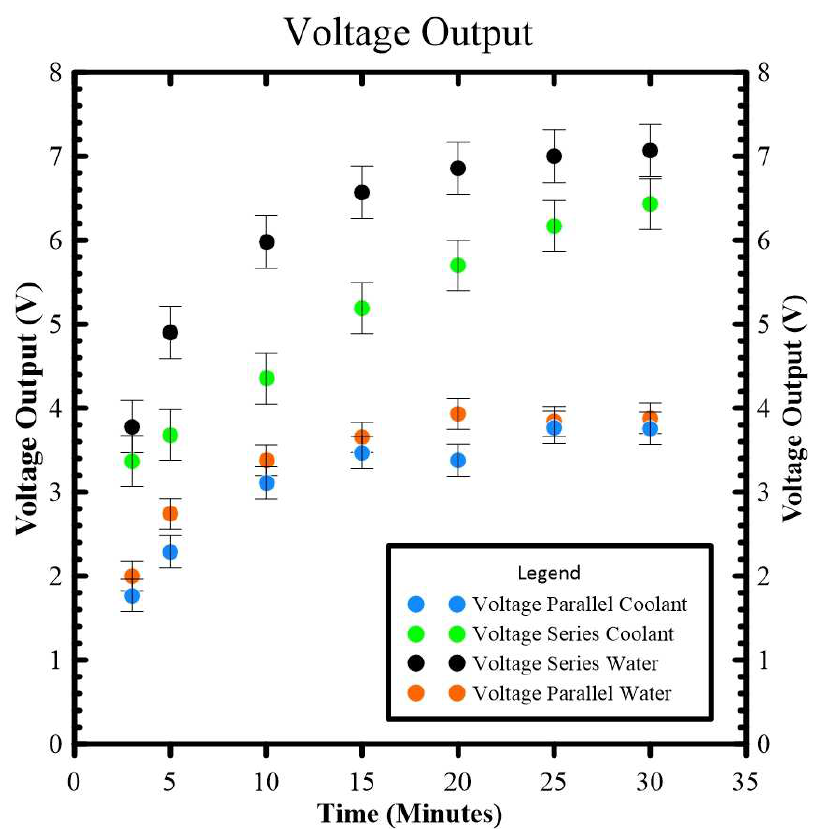
Figure 19. Voltage measurement for a two-TEG system .